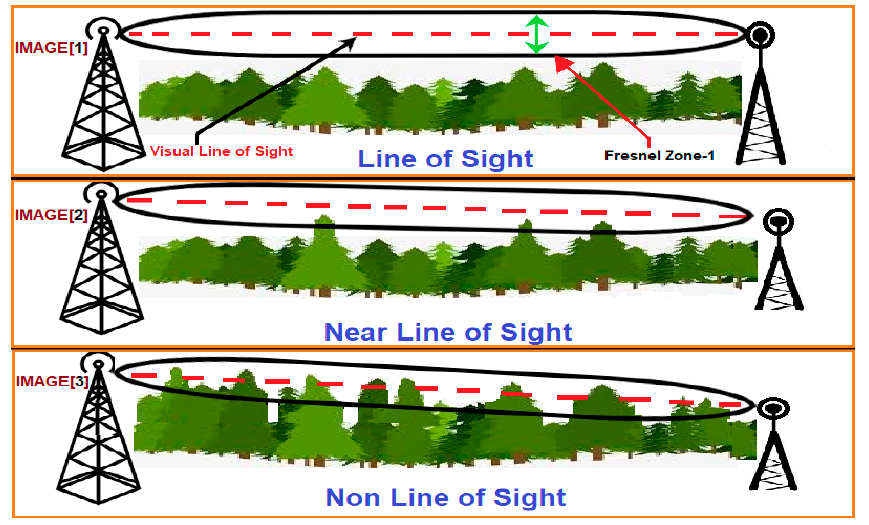
Figure 11. Illustration of line-of-sight point-to-point wireless communication. Image 3 shows how the trees act as obstacles that can affect signal performance.